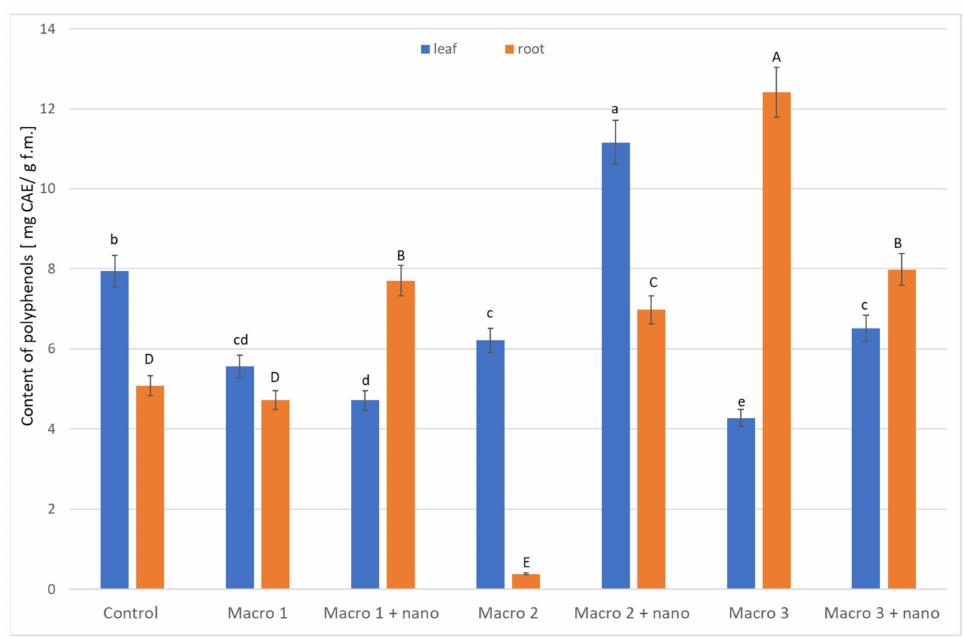
Figure 3. The content of polyphenols [mg CAE g − 1 fresh weight] in the shoots and roots of plants grown in soil supplemented macronutrients or macronutrients and nanoparticles. Vertical bars represent the mean values (n = 5) ± standard deviations. Different letters indicate significant difference at p < 0.05 by LSD